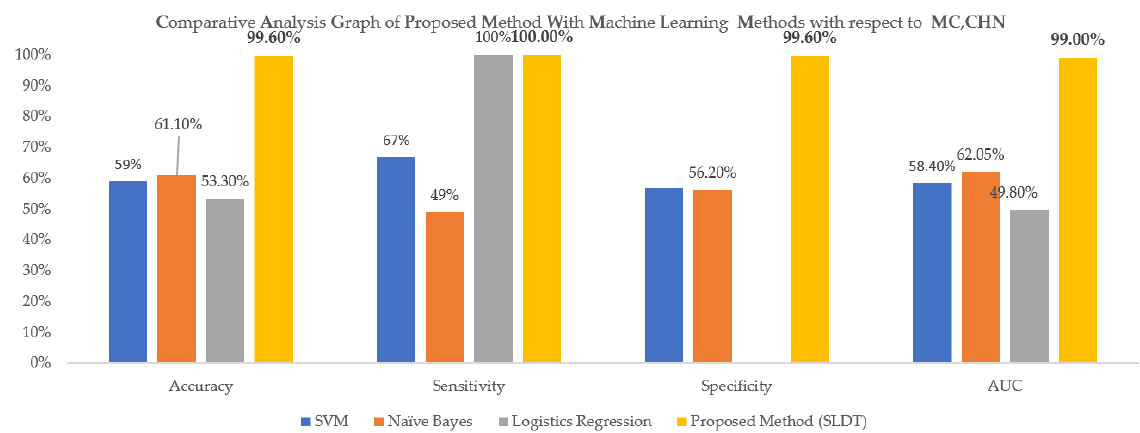
Figure 13. Comparative analysis graph of the proposed method with the machine learning methods with respect to the combined dataset 1 (MC and CHN).